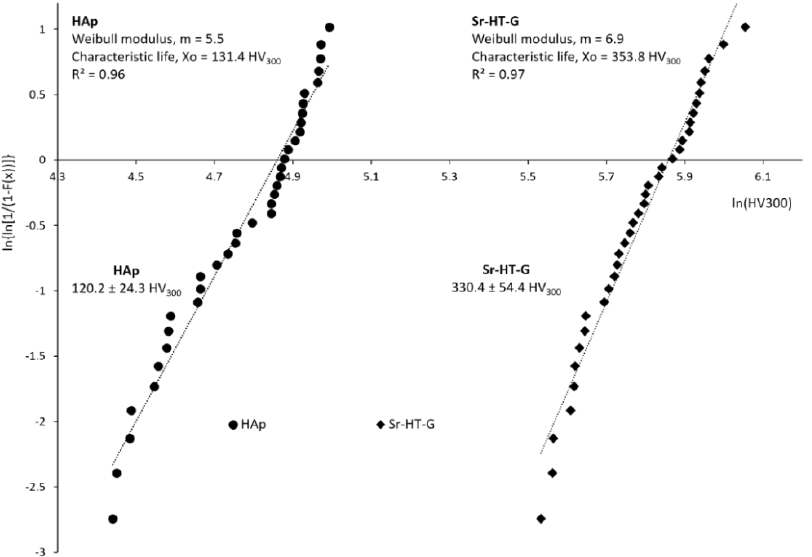
Figure 6. Weibull regression analysis of the Vickers hardness test of HAp and Sr–HT–G coatings.